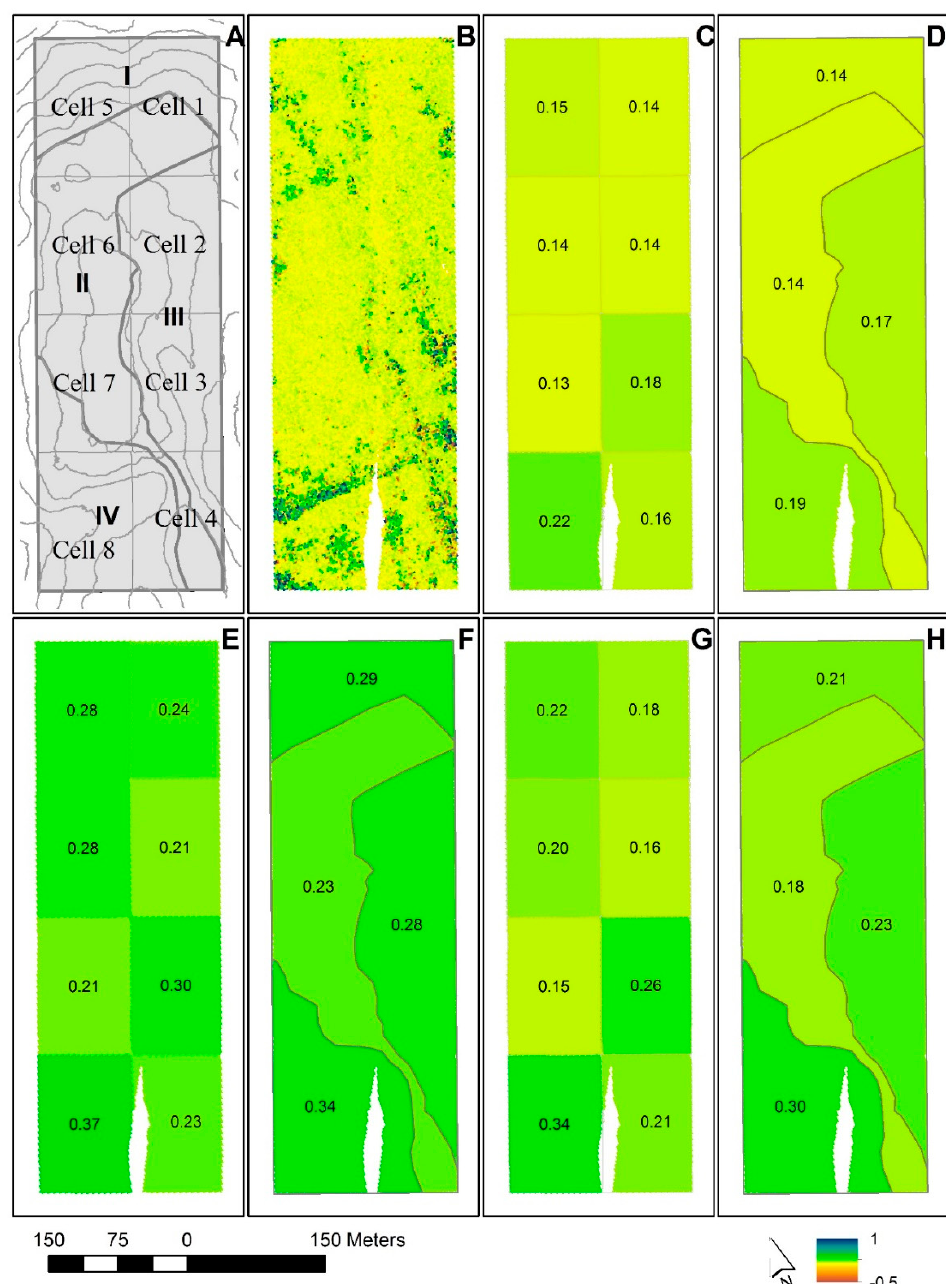
Figure 6. ( A ) Study area with 5 m counter lines, the eight tessellated cells of Case A (Cell 1–8), and boundaries of the sub-regions for Case B (I–IV); ( B ) predictions of vegetation height change for the 2 m 2 population elements; ( C ) estimated mean vegetation height change for tessellated cells of Case A; ( D ) estimated mean vegetation height change for sub-regions of Case B; ( E ) estimated mean tree height change for Alternative 1 for tessellated cells of Case A; ( F ) estimated mean tree height change for Alternative 1 for sub-regions of Case B; ( G ) estimated mean tree height change for Alternative 2 for tessellated cells of Case A; ( H ) estimated mean tree height change for Alternative 2 for sub-regions of Case B. The height change estimates for each domain in ( C – H ) are given by numbers. The white area in the lower part of B–H is due to missing ALS data in the 2006 acquisition.